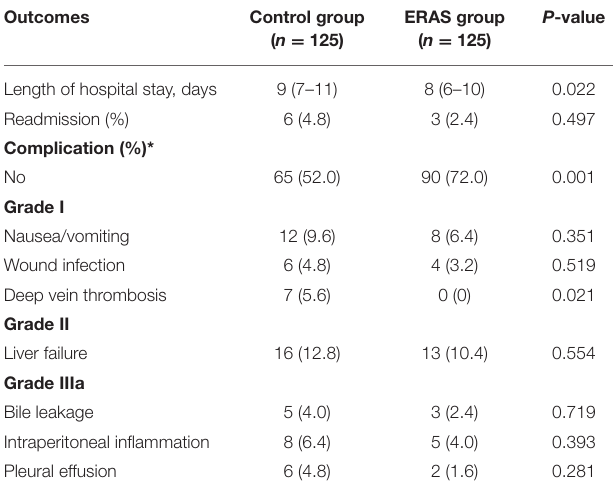
TABLE 3 | Clinical outcomes of all patients divided into ERAS and control